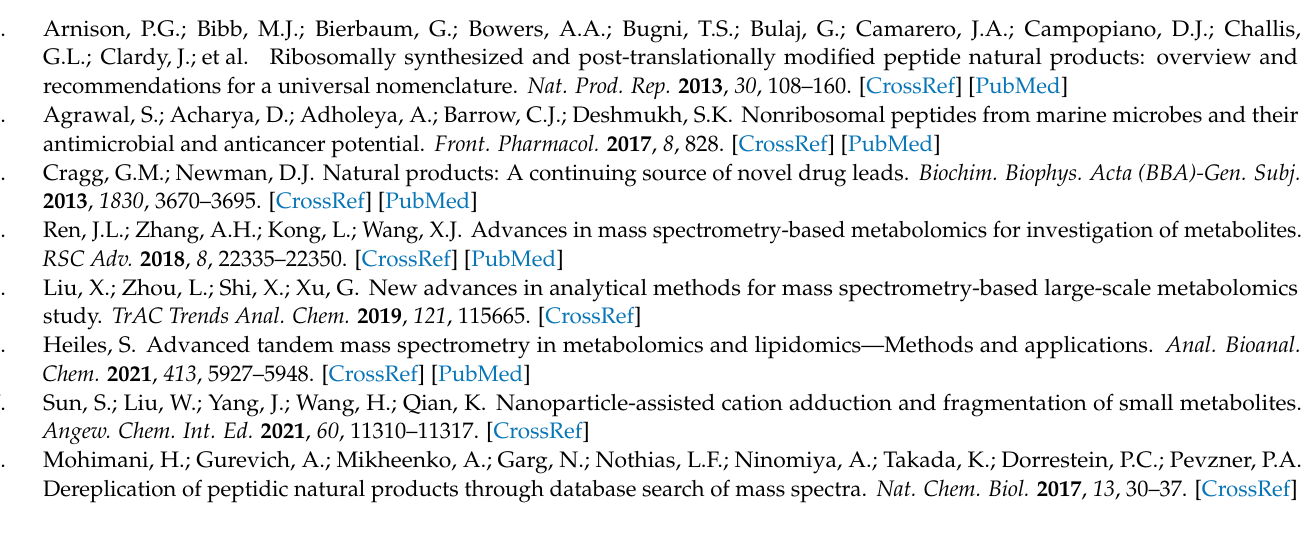
NPvis matching algorithm overview, Figure S3: The NPvis web server visualisation of surugamide B mass spectrum, Figure S4: The NPvis integration with